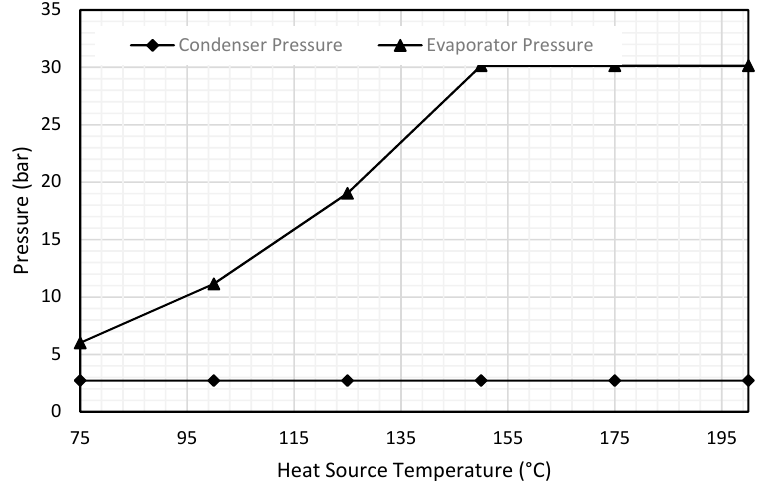
Figure 10. Variation in Evaporator and Condenser pressure with changing heat source temperature for Beijing’s ambient conditions.